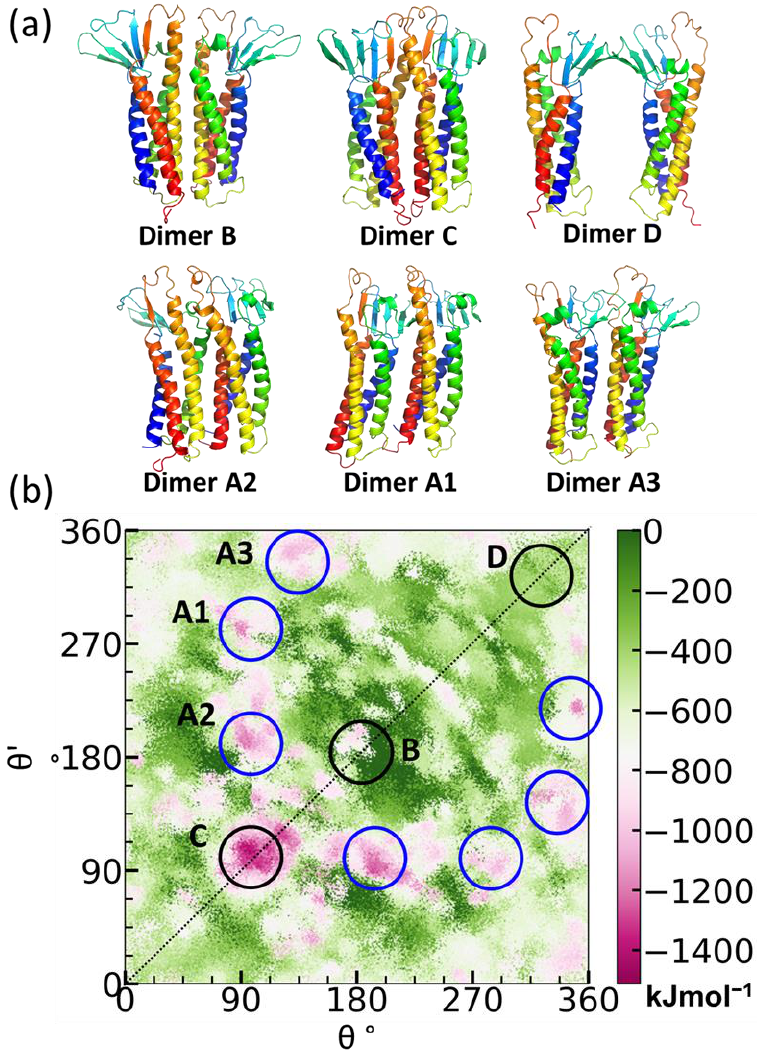
Figure 7. Claudin-5 cis dimerization. ( a ) Key cis dimers formed in claudin-5, reverse mapped to atomistic resolutions, and ( b ) PANEL plot showing location of low energy dimers A1, A2, and A3 (blue circles); and dimers B, C, and D (black circles).